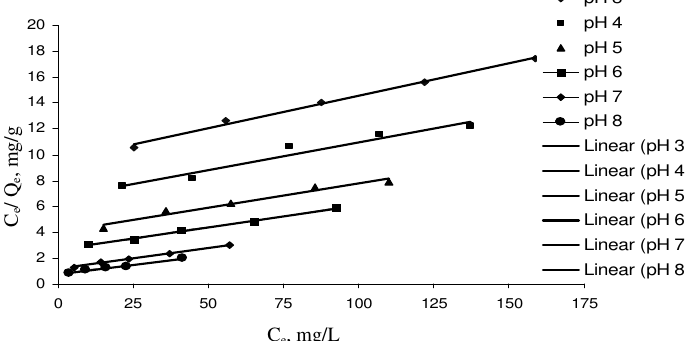
Figure 2 . Linearized Langmuir isotherms at different solution pH